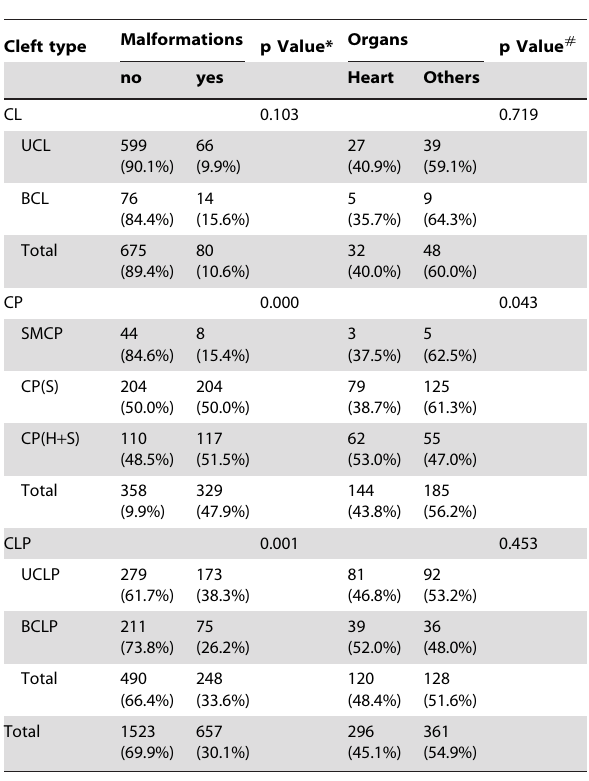
Table 2. Distribution of clefts by malformations and